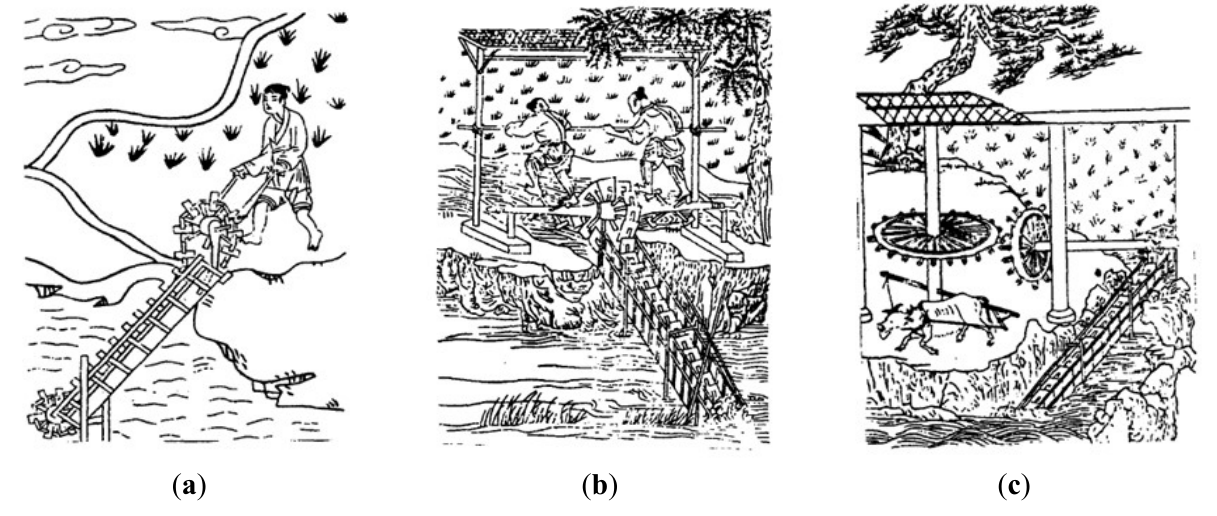
Figure 15. Three types of Dragon backbones during the Tang and Song dynasties: ( a ) hand-operated; ( b ) foot operated; and ( c ) oxen powered